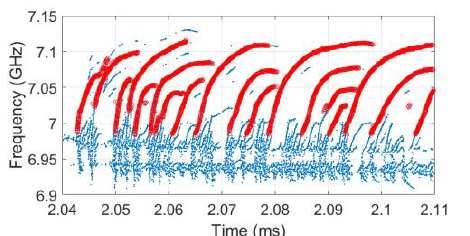
Fig. 3. Selection of single rising tones in the dynamic spectrum shown in fig. 2a (upper